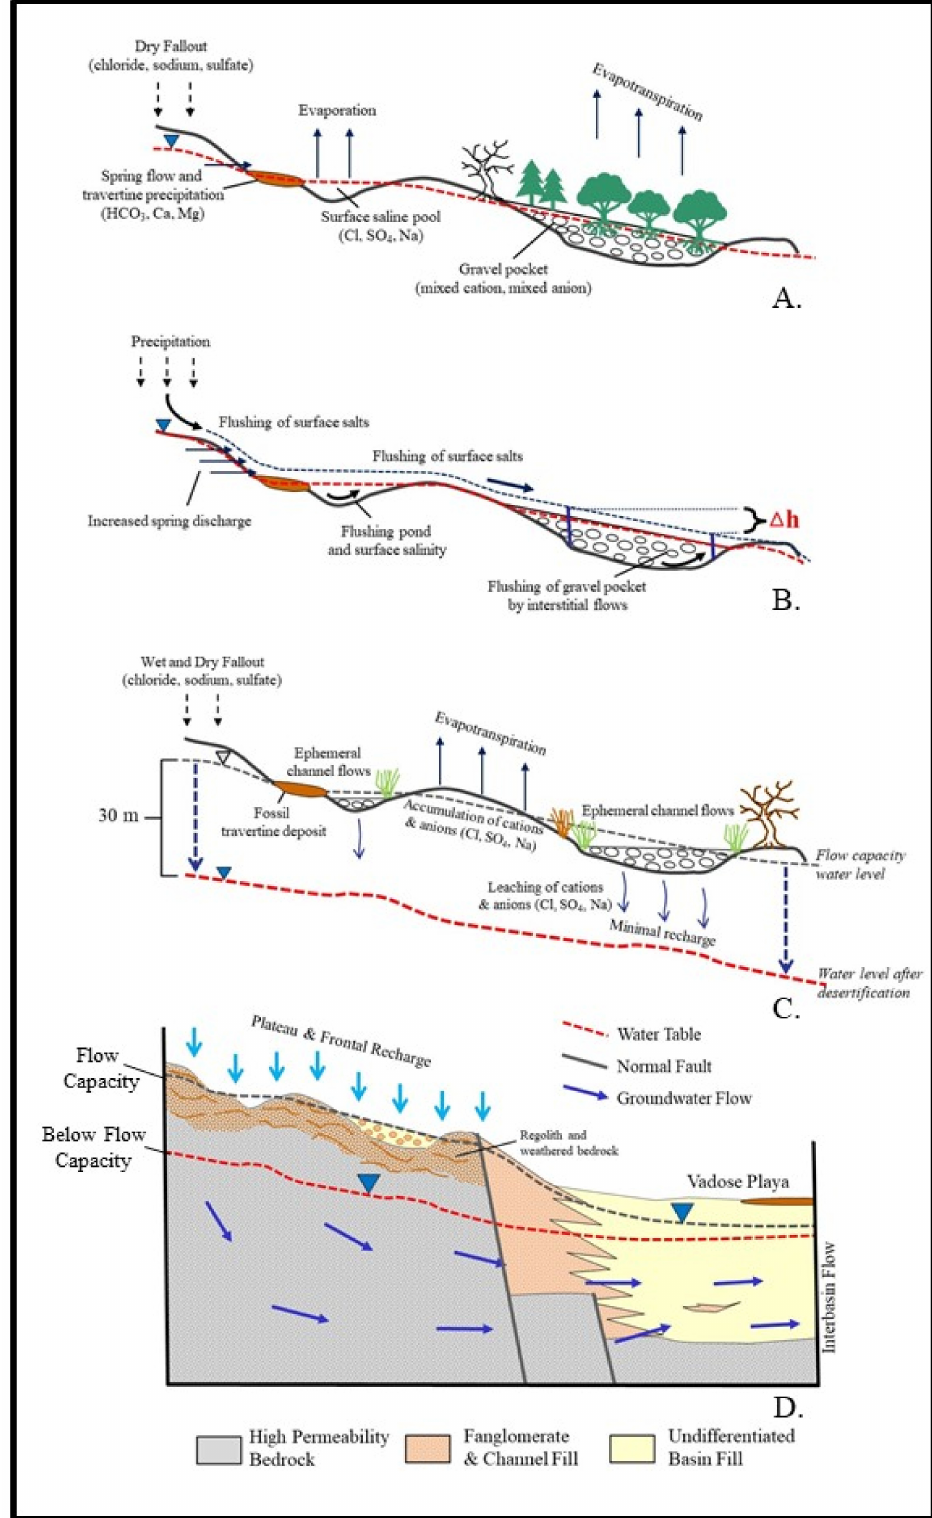
Figure 4. Flow capacity in mountain areas occurs more regionally when the highlands have mod- erately gentle topography, such as is found in mesas and plateaus. ( A , B ) show processes when gently sloping highlands are at flow capacity. ( C ) shows salt accumulation in interchannel areas and percolation of salts with downward moving wetting fronts in channel areas. ( D ) shows full model perspective in mountain/plateau and basin floor areas (( A , B ) modified from